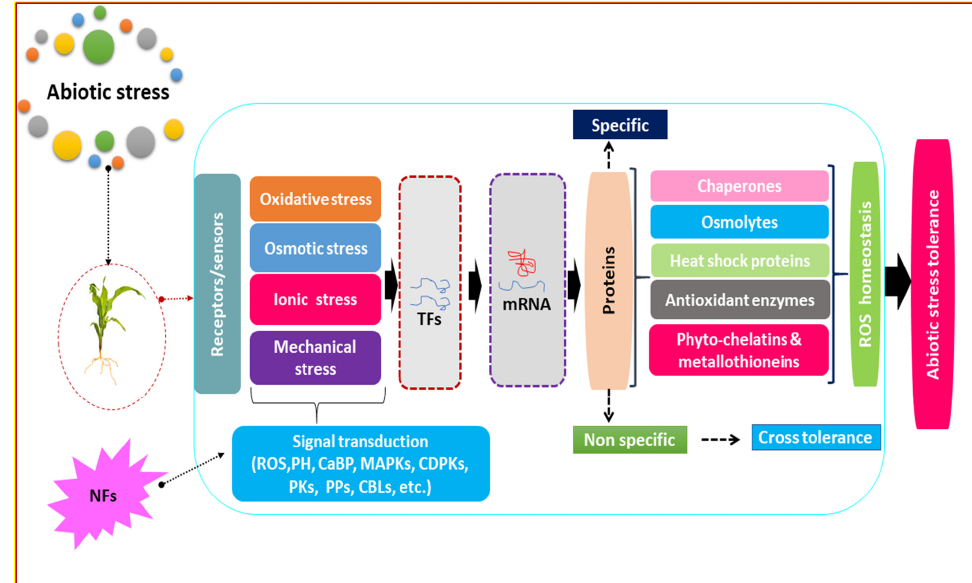
Figure 3. NFs with a variety of defense mechanisms in plants under stress. Early prevalence of stress sensing via receptors/sensors cascades the downstream stress response by ROS, CaBP (Ca 2+ binding proteins), and plant hormones. Signal extension and transduction is carried out by secondary messengers, i.e., MAPKs (mitogen-activated protein kinases), PKs (ROS-modulated protein kinases), PPs (protein phosphatases), CDPKs (calcium-dependent protein kinases), etc. Signaling causes various regulation of transcription factors (TFs) and stress-responsive genes. Control of TFs and genes linked with physiological, biochemical, and molecular responses may adjust to fine-tune enhanced stress resistance capacity.